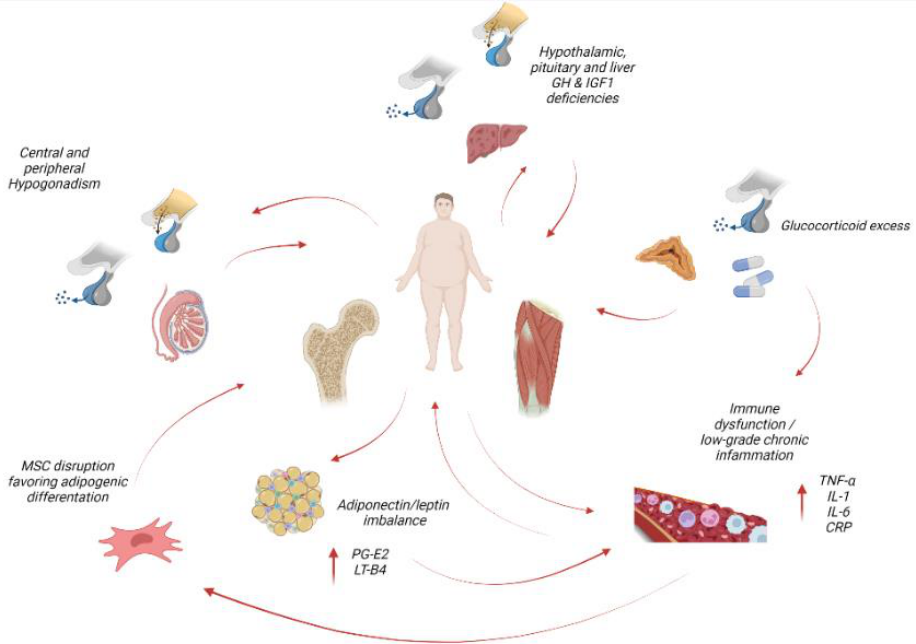
Figure 1. Role of endocrine and inflammatory/immune dysregulation in the pathogenesis of osteosar- copenic obesity. Red, curved arrows: negative influence; bidirectional red curved arrows indicate mutual influences perpetuating the pathogenic vicious cycle. Upward arrows indicate an increase. Causes of glucocorticoid excess include Cushing disease/syndrome, aging, sleep deprivation, stress, steroid therapy; ageing is associated with GH, IGF1 and androgen deficiency; adipose tissue dys- function triggers low-grade chronic inflammation. See text for detailed explanation. GH, growth hormone; IGF1, insulin-like growth factor 1; TNF- α , tumor necrosis factor-alpha; IL-1, interleukin 1; IL-6, interleukin 6; CRP, C-reactive protein; PG-E2, prostaglandin E 2 ; LT-B4, leukotriene B4. Created with BioRender.com, accessed on 31 March